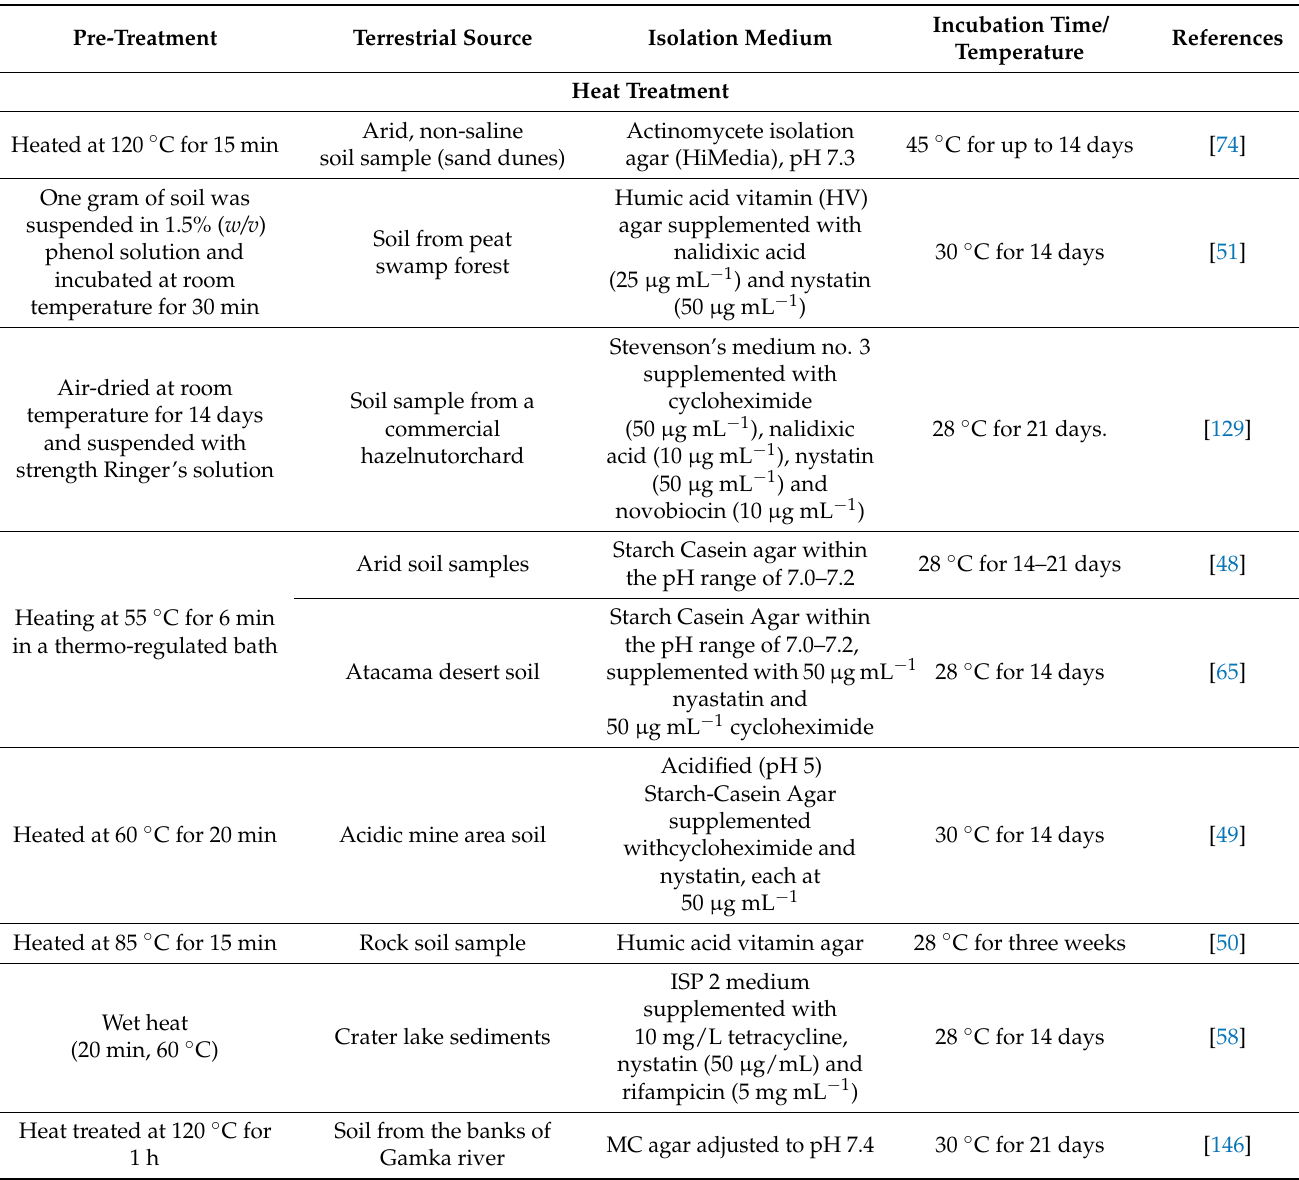
Table 5. Different pre-treatments employed for the isolation of novel Streptomyces spp. terrestrial samples between 2015 and